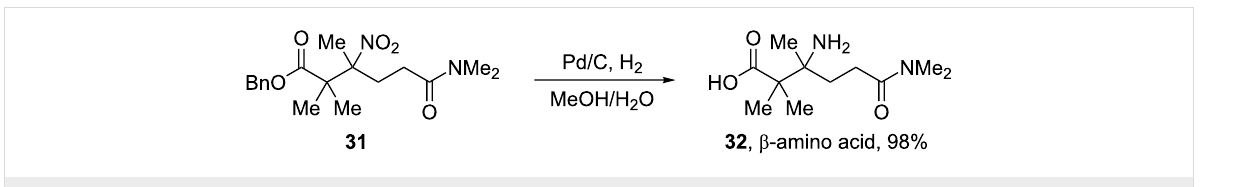
Scheme 6: Scope of the reaction of nitroalkanes with α -bromocarbonyls.